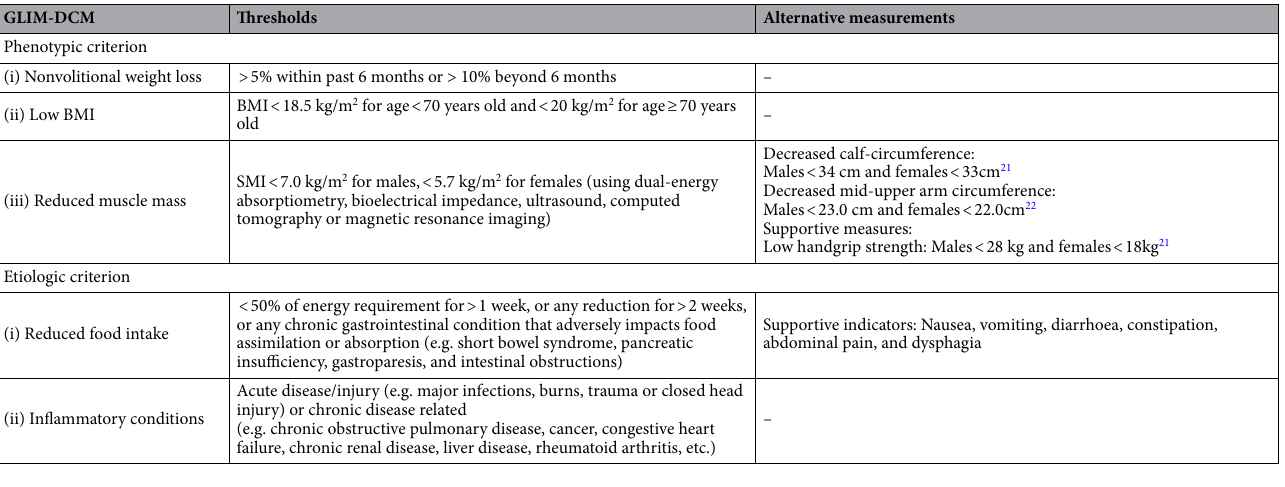
Table 2. Phenotypic and etiologic criteria for the diagnosis of malnutrition by GLIM. Source : Cederholm et al. 9 . BMI Body mass index, SMI Skeletal muscle mass.